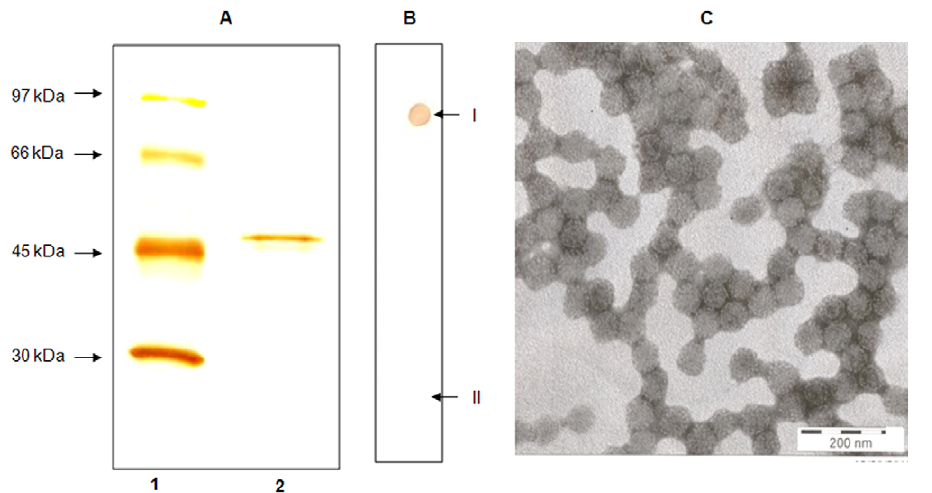
Figure 3. Characterization of MCPyV VP1 antigens. Silver staining of capsid protein (panel A) in 10% SDS PAGE. Lane 1: molecular weight markers, lane 2: MCPyV VP1 capsid antigen. Dot blotting (panel B) for MCPyV antigen, studied with MCPyV-IgG positive (I) and negative (II) sera. Electron microscopy of sterile MCPyV particles (panel C) purified by caesium chloride density gradient ultracentrifugation, with 200 nm scale bar shown.